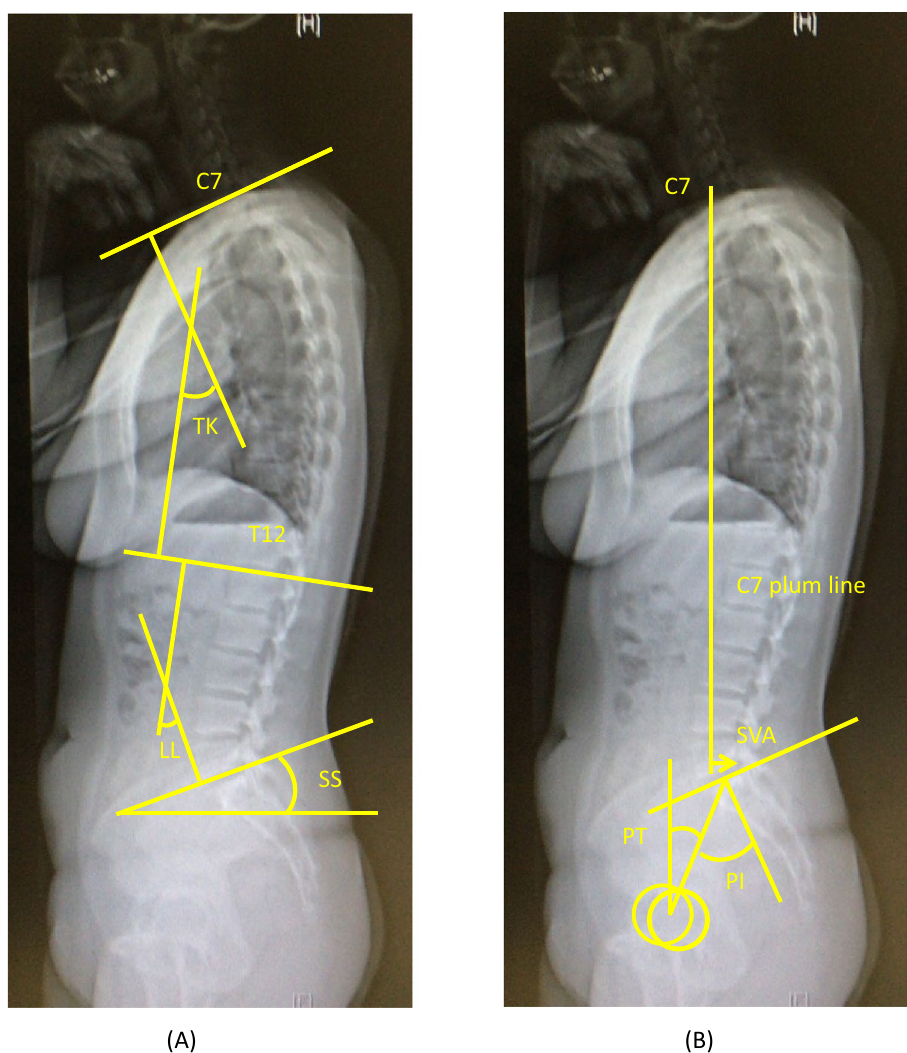
Figure 1. Whole spine radiographic measurements. ( a ) Measurement of thoracic kyphosis (TK), lumbar lordosis (LL) and sacral slope (SS). ( b ) Measurement of diameter of sagittal vertical axis at C7(C7-SVA), pelvic tilt (PT), and pelvic incidence (PI). Pelvic tilt (PT) is defined by the angle between the vertical and the line through the midpoint of the sacral plate to the femoral heads axis (retroversion is then measured as a pelvic tilt increase, anteversion as a pelvic tilt decreases). Sacral slope (SS) is defined as the angle between the horizontal and the sacral plate. Pelvic incidence (PI) is defined as the angle between the perpendicular to the sacral plate at its midpoint and the line connecting this point to the femoral heads